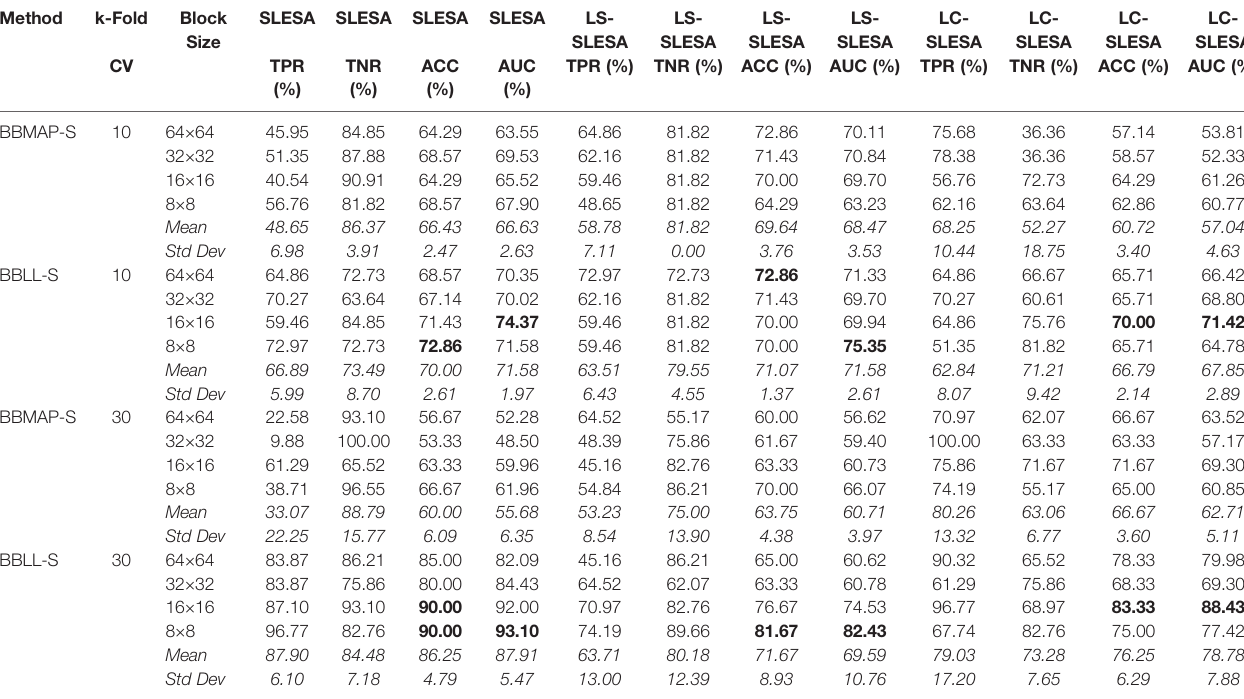
TABLE 3 | Breast mass classi fi cation performance on MIAS data using ensembles of block-based sparse classi fi ers with dictionary learning (ROI size: 64×64 ). Method k-Fold